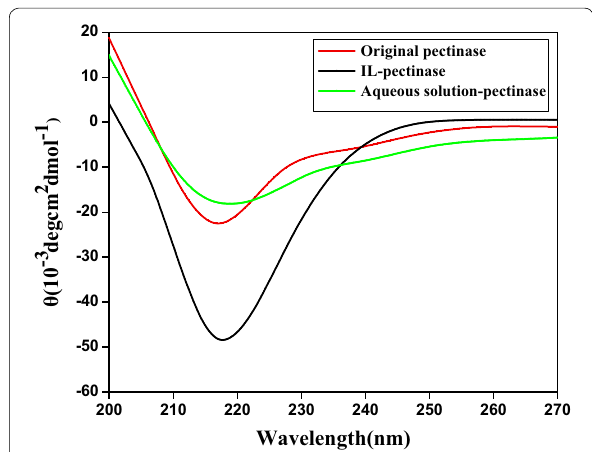
Fig. 5 CD spectra of original pectinase, aqueous solution pectinase, and pectinase treated with ILs